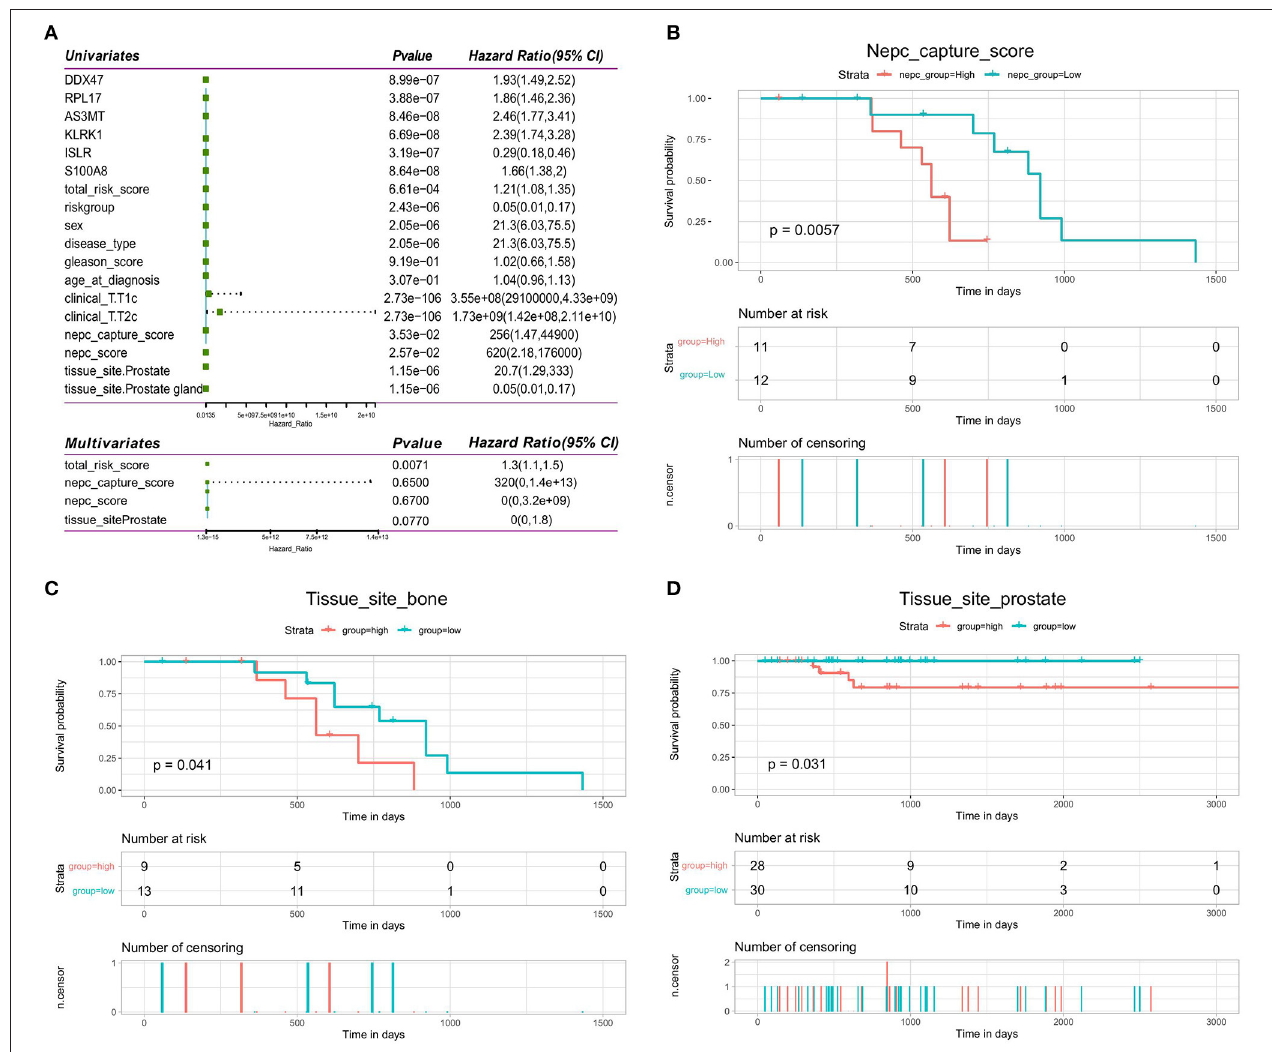
FIGURE 11 | Validation of independence of bone metastasis-related prognostic models. (A) Forest plot of single-factor regression analysis and multifactor regression analysis. (B) Kaplan-Meier analysis of prognosis for the high- and low-NEPC score groups. (C,D) Kaplan-Meier analysis of the high- and low-risk groups for the clinical factor tissue site (bone and